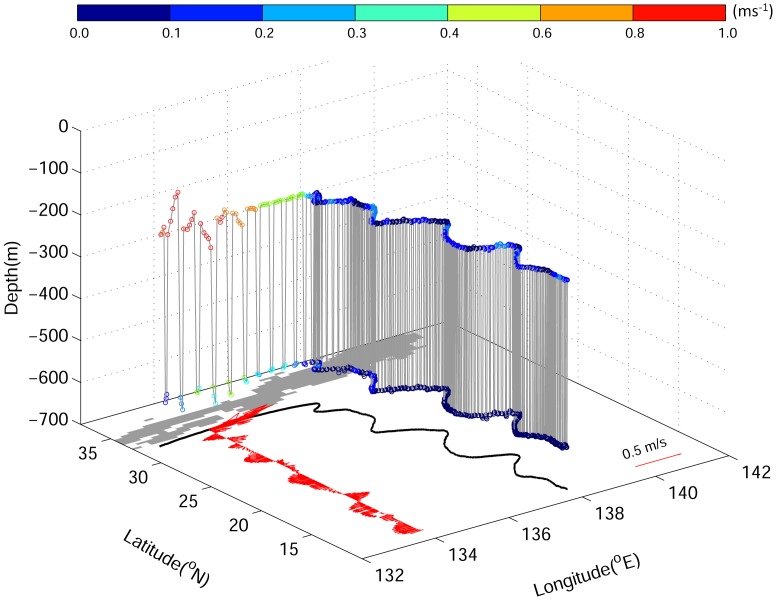
An example of the 3D trajectories of v-eel in Exp. 3A (true navigation, 0.15 m s−1). Colored dots are the ocean current speed.The black curve is the horizontal projection of the migration path. Red arrows are the along-path ocean velocities.